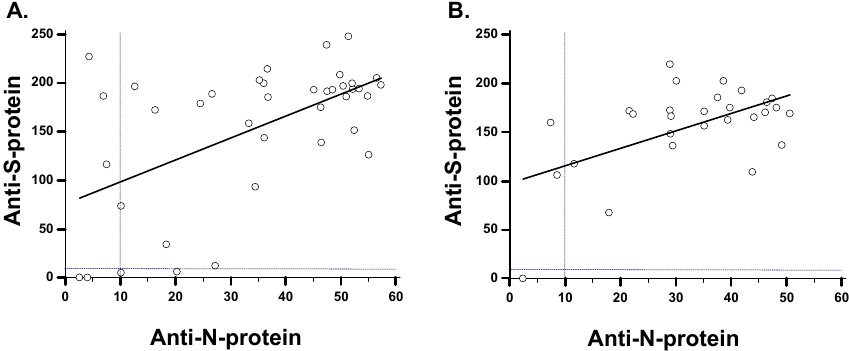
Figure 5. Association of anti-N-protein and anti-S-protein antibodies. The scatter plot and linear regression analyses of anti-N-protein versus anti-S-protein antibody levels. ( A ) Day 2 or day 3 PCOS; r = 2.7 (95% CI 1.7–3.75) p = 0.0001. ( B ) Day 16 or 17 POCS; r = 2.3 (95% CI 1.8–3.4), p = 0.0002. The dotted vertical and horizontal lines represent the cut-offs for positive reactivity in the respective ELISAs.